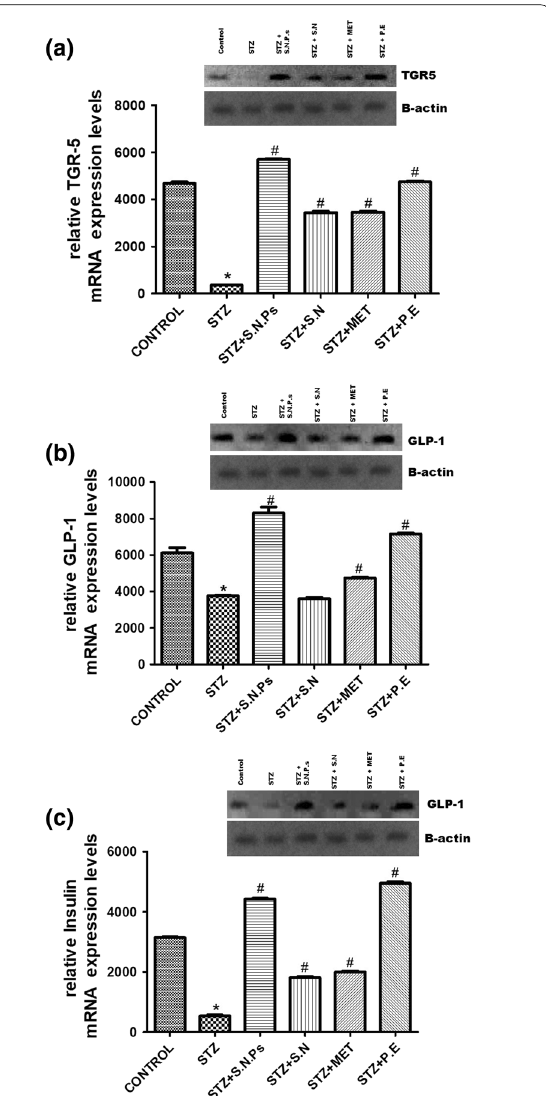
Fig. 9 a A snapshot representation of the densitometric evaluation of agarose gel electrophoresis of the RT-PCR analysis of TGR5 gene expression. * represents statistical difference to control ( p < 0.05) while # represents statistical difference to diabetic control ( p < 0.05). b A snapshot representation of the densitometric evaluation of agarose gel electrophoresis of the RT-PCR analysis of GLP-1 gene expression. * represents statistical difference to control ( p < 0.05) while # represents statistical difference to diabetic control ( p < 0.05). c A snapshot representation of the densitometric evaluation of agarose gel electrophoresis of the RT-PCR analysis of insulin gene expression. * represents statistical difference to control ( p < 0.05) while # represents statistical difference to diabetic control ( p <